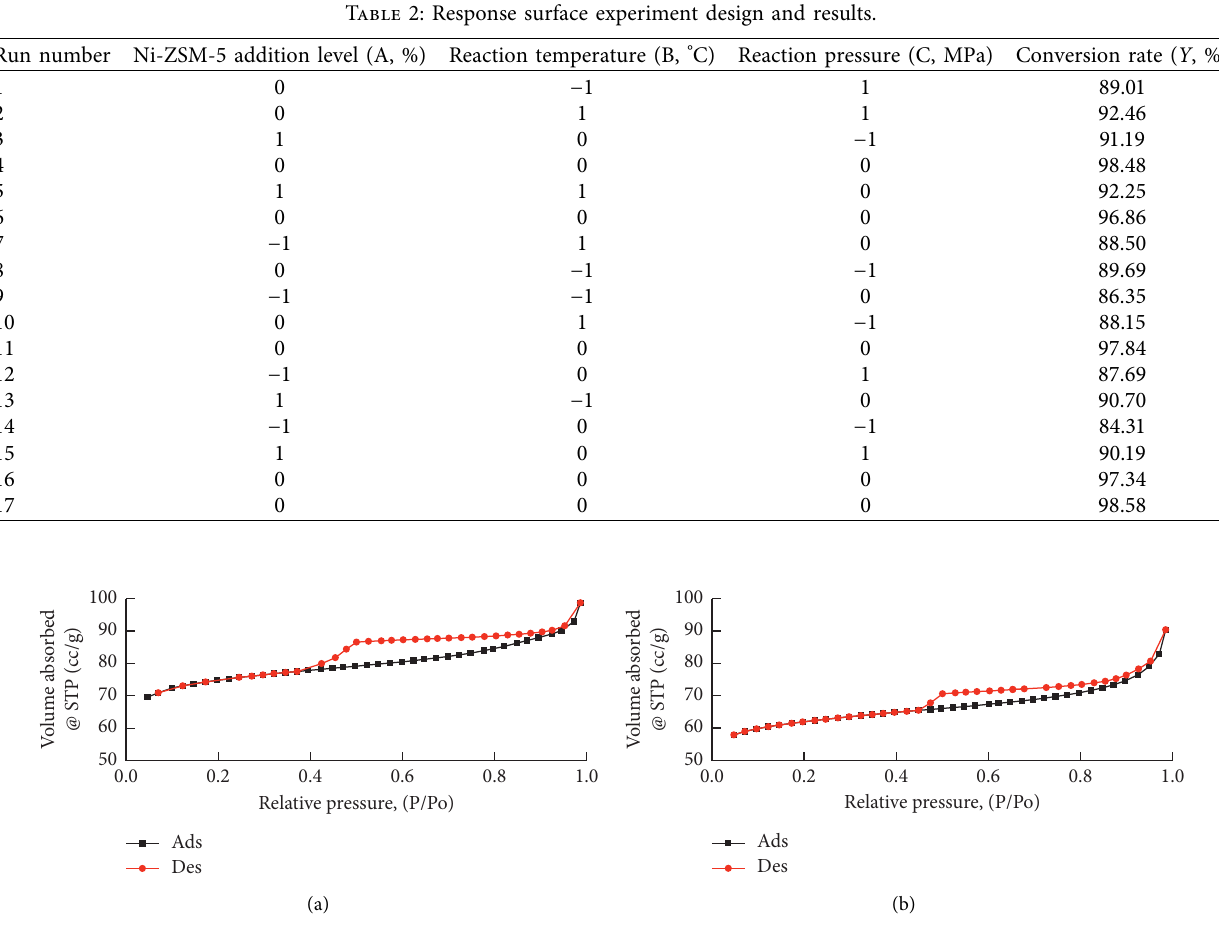
Figure 2: N 2 adsorption-desorption isotherms of the ZSM-5 and Ni/ZSM-5 catalysts. (a) Ni-ZSM-5; (b)